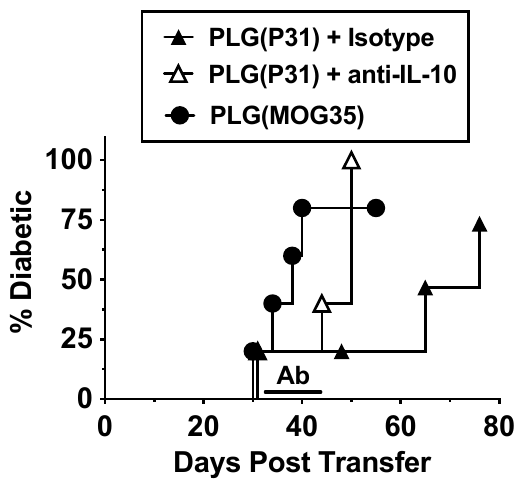
Figure 6. Tolerance in BDC-2.5 transfer model IL-10-dependent. NOD. scid mice were treated with either PLG(P31) or PLG(MOG35) within 24 h following adoptive transfer of 10 × 10 6 P31-activated transgenic BDC-2.5 T cells and monitored for blood glucose levels. Mice were treated with isotype control or monoclonal anti-IL-10 (JES5-2A5) antibody from days 31 to 40 after transfer.